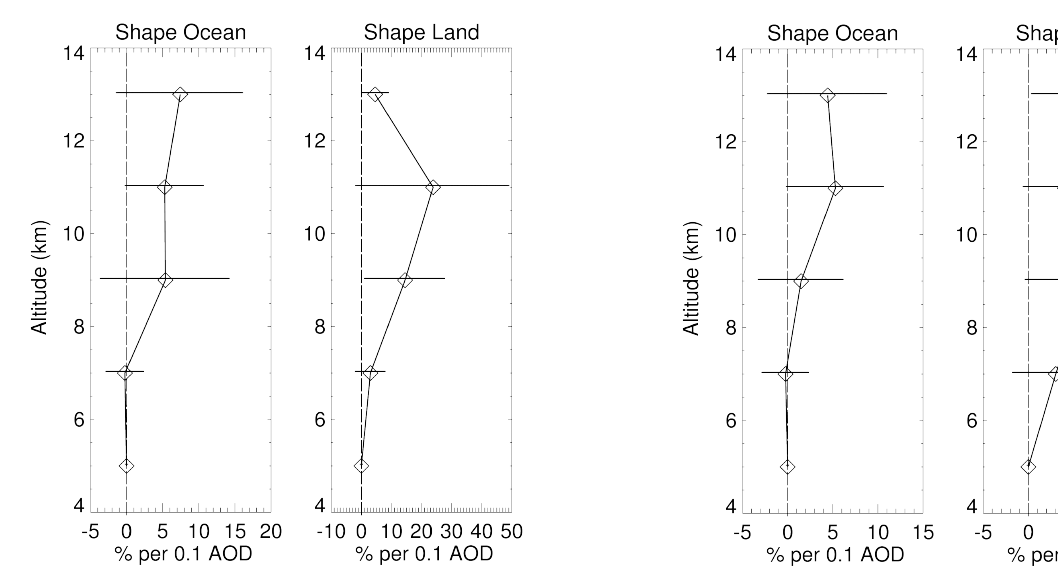
Figure 11. Same as Fig. 9 except that IWC shape derivatives less than 100% per 0.1 AOD are excluded from the averaging